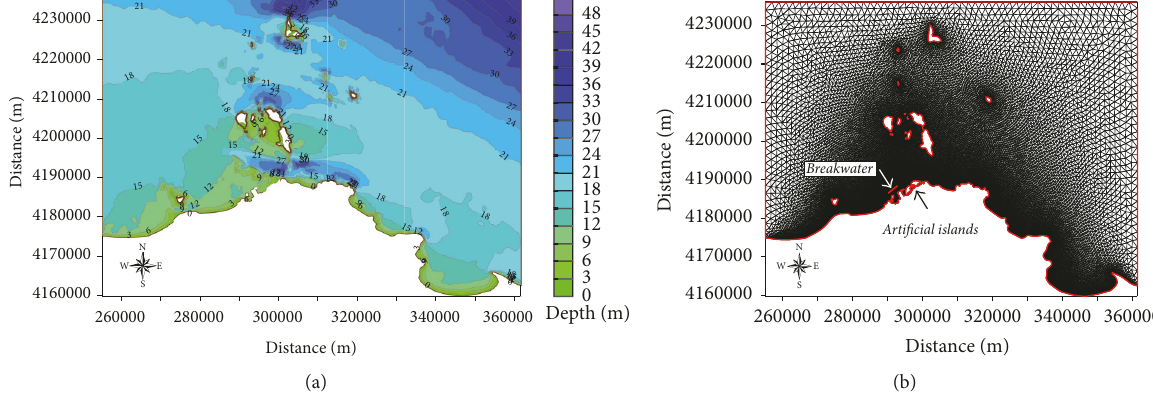
Figure 8: (a) Bathymetry and (b) unstructured grids for the model domain.